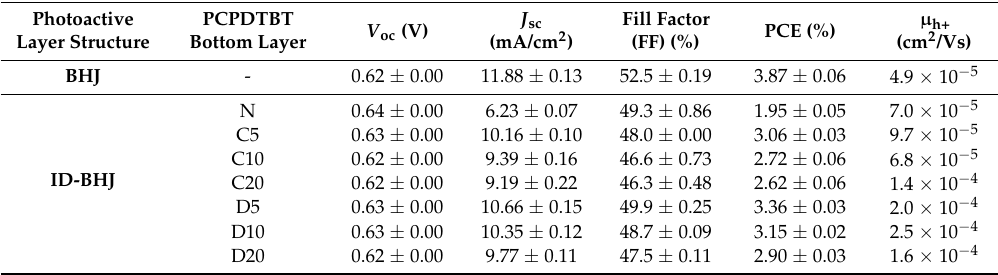
Table 4. Photovoltaic parameters and hole mobility of ID-BHJ OPVs using different polymer bottom